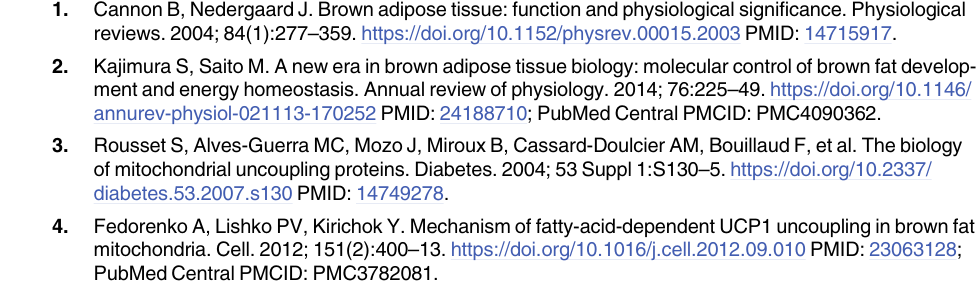
S1 Table. RT-qPCR